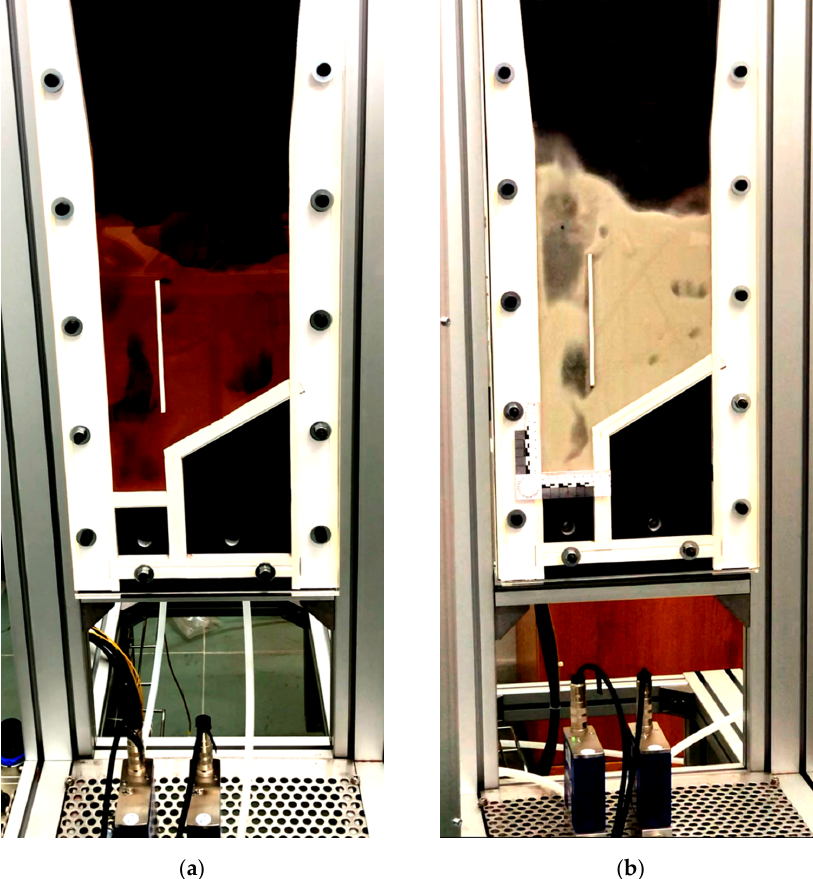
Figure 3. ENEA’s ICBFB pseudo-2D cold model test ring implementing LaVision PIV system for velocity field evaluations. Images of test conducted with: ( a ) 0.14 mm copper powder particles; ( b ) 0.55 mm glass beads.